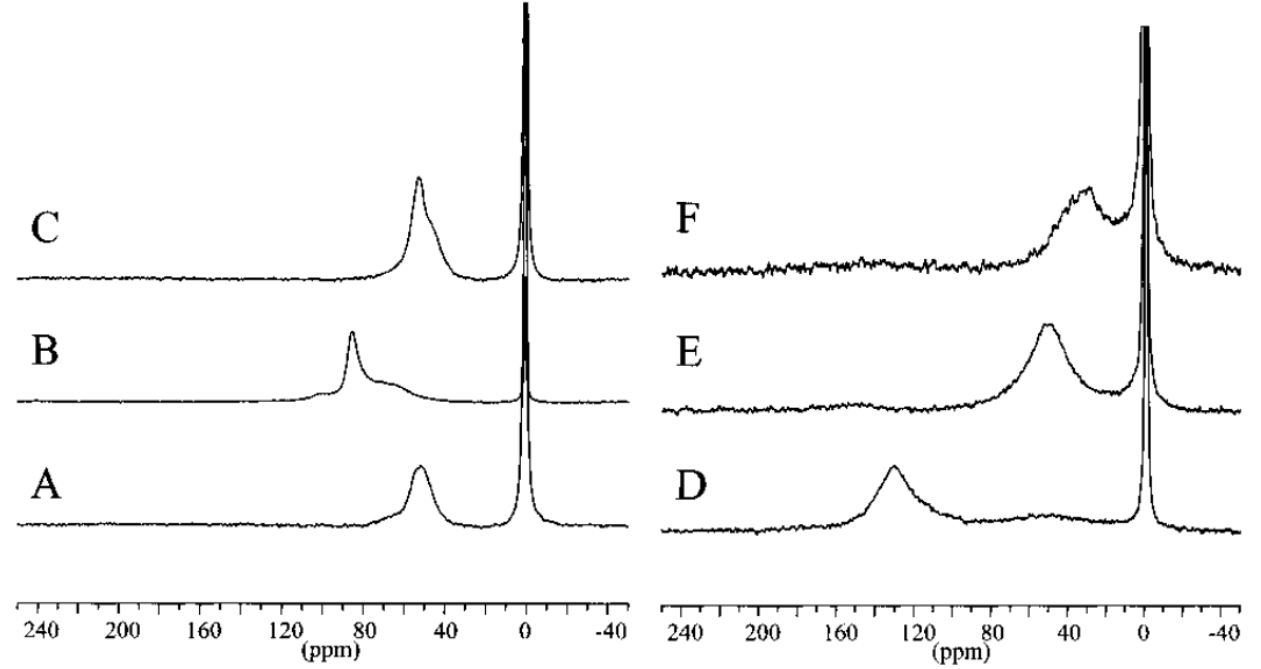
Figure 7. Room temperature continuous flow hyperpolarized 129 Xe NMR spectra of ordered meso- porous silica (OMS) materials and their functionalized counterparts (referred to as PNNL) with different pore sizes: 5 nm, 9.3 nm, and 30 nm. ( A ) OMS-5, ( B ) OMS-9.3, ( C ) OMS-30, ( D ) PNNL-5, ( E ) PNNL-9.3, ( F ) PNNL-30. Reprinted with permission from reference [9]. Copyright 2002 American Chemical